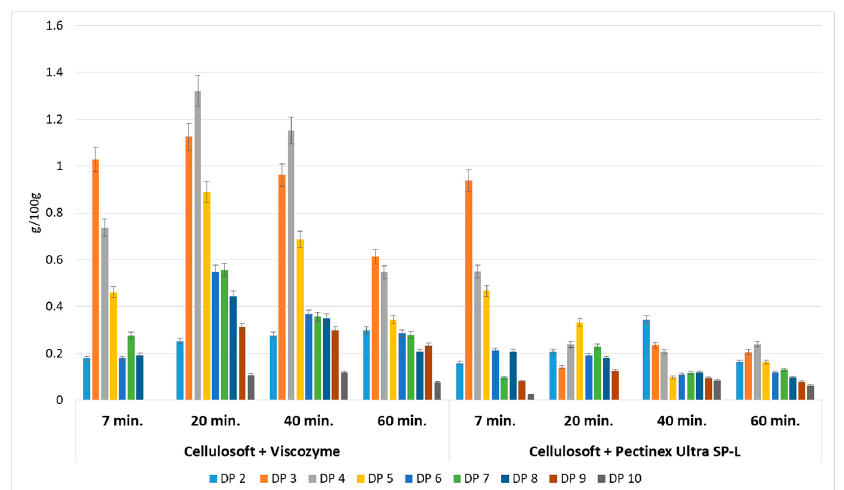
Figure 1. Yield of oligosaccharides with different degrees of polymerization obtained by enzymatic hydrolysis of apple pomace. Data represent mean from two independent experiments repeated three times. Error bars denote standard deviation (SD). Degree of polymerization (DP).